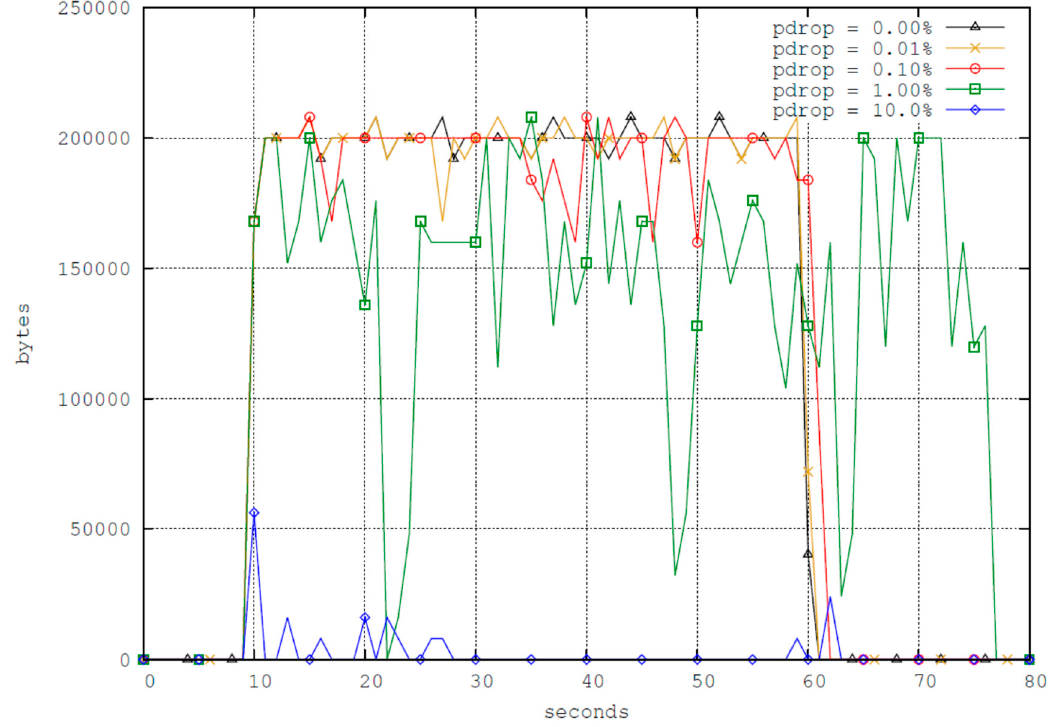
Figure 8. Figure 7 is redrawn for the first 80 s of simulation time.